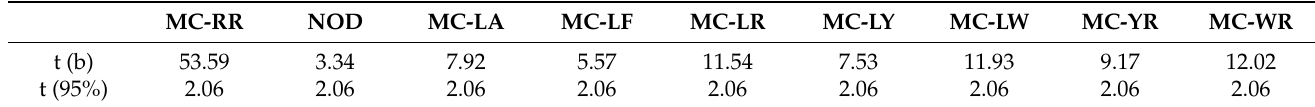
Figure 2. Matrix effect assessment for the different microcystin congeners and nodularin in drinking water. The presence of a matrix effect was established by comparing the difference in slope based on a student t -test. However, also a visual assessment can be made. If the curve runs in parallel, there is no matrix effect. If this is not the case, there is a matrix effect. All toxins displayed matrix effect in drinking water. Table 3. Values for the calculated t (b) is compared with the tabulated t at the 95% confidence level. If t (b) is higher than t (95%), a matrix effect is